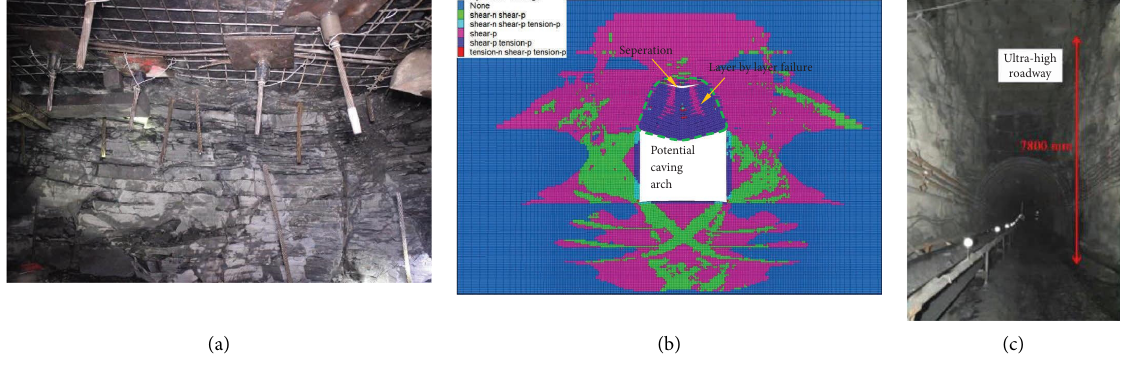
Figure 3: Formation mechanism of ultrahigh roadway: (a) exposed roof; (b) roof failure mode; (c) ultrahigh